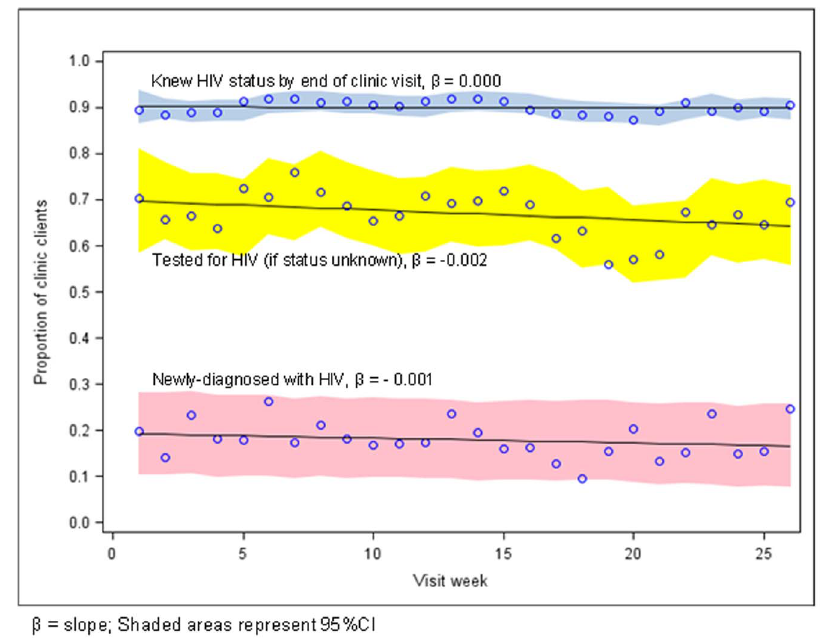
Figure 1. Systematic HIV counseling and testing at primary care clinic in Johannesburg, South Africa: coverage, case detection and sustainability over a 26-week period.